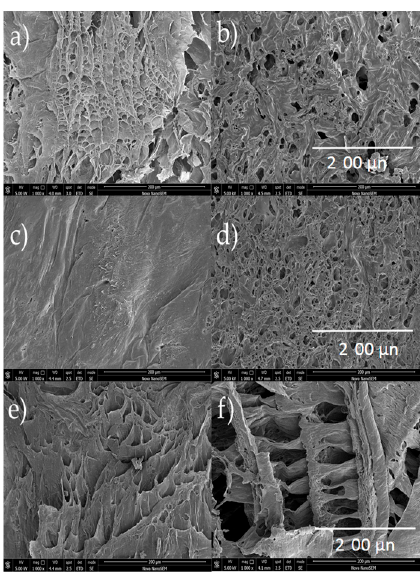
Figure 6. SEM images of surface for CPS ( left ) and nCPS ( right ) at 1000×. ( a ) CH:PVA 1:1 GLU-GLY; ( b ) CH:PVA 1:1; ( c ) CH:PVA 1:3 GLU-GLY; ( d ) CH:PVA 1:3; ( e ) CH:PVA 3:1 GLU-GLY; ( f ) CH:PVA 3:1.